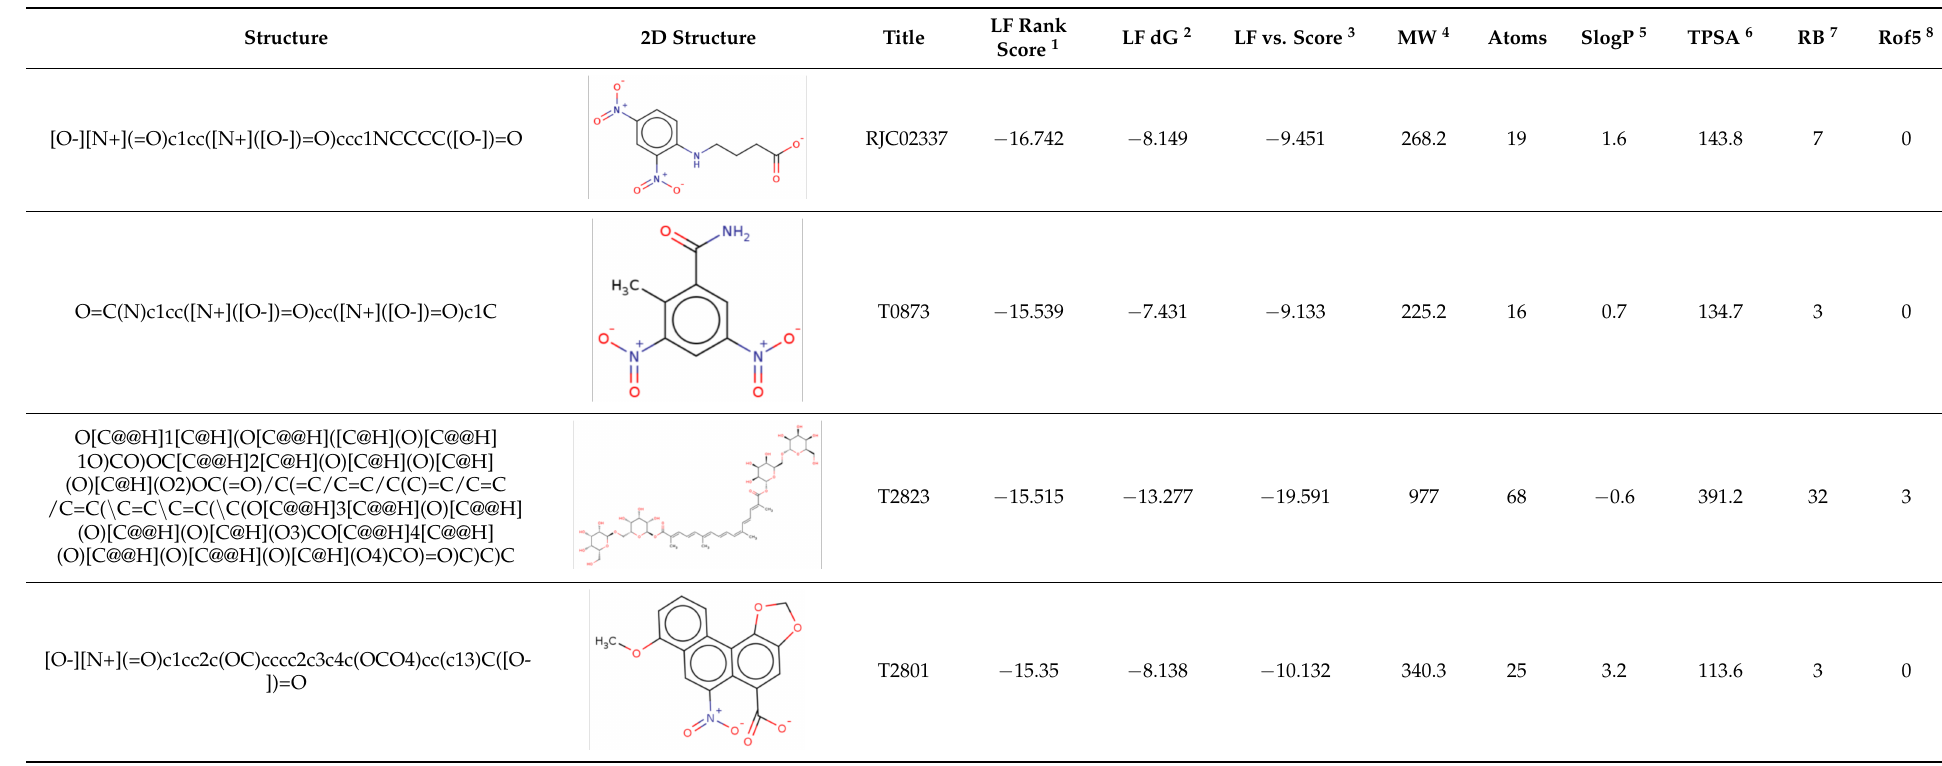
Table 1. The docking score and binding energy of the top five compounds docked against PfDegP within the allosteric pocket (S2).